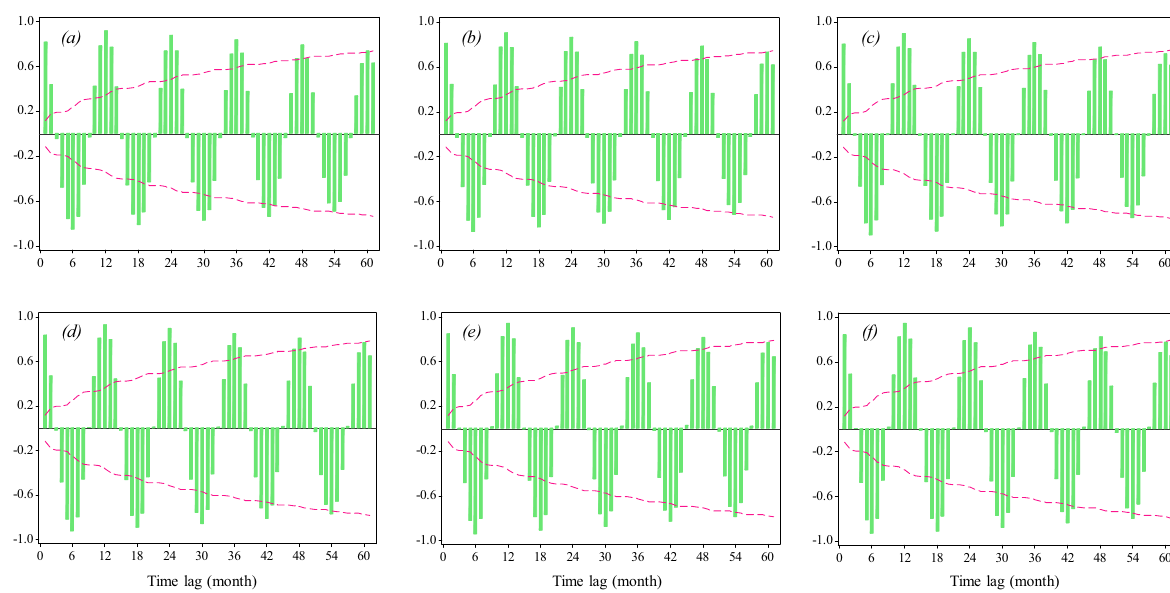
Figure 5. Autocorrelation plots for the monthly ET0 time series; the alphabets within the brackets refer to the stations: ( a ) Bandar Anzali, ( b ) Ramsar, ( c ) Gharakhil, ( d ) Ahwaz, ( e ) Shiraz, ( f )